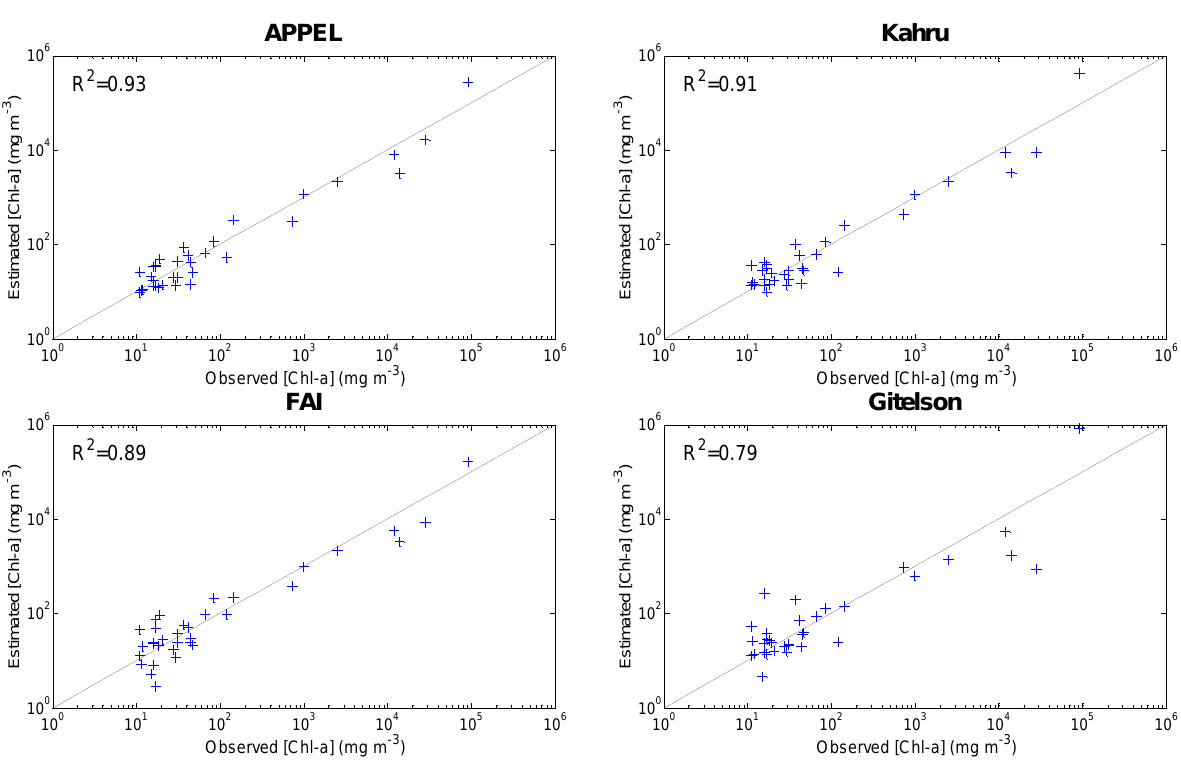
Figure 7. Chlorophyll-a concentration estimated from the four models compared to in situ measurements (data set Chl-a > 10 mg∙m –3